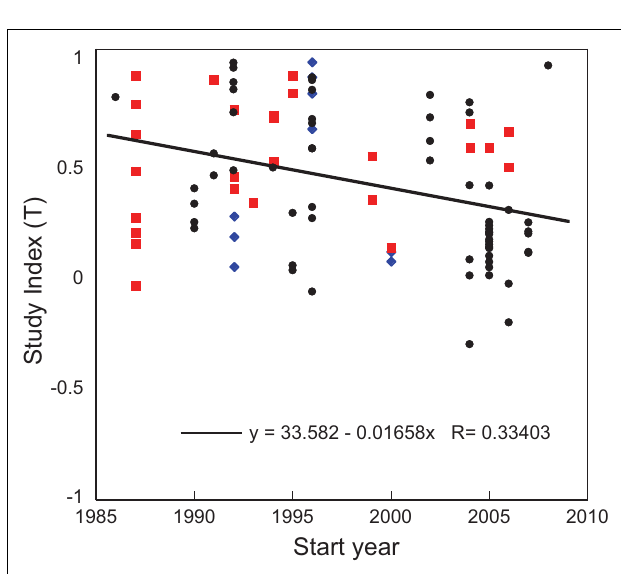
FIGURE 2 | Regression of study index, T , on the start year in control plots. The temperate sites are shown in back circles, boreal sites are blue diamonds, and the tropical sites are red squares.The regression line is shown for all points.